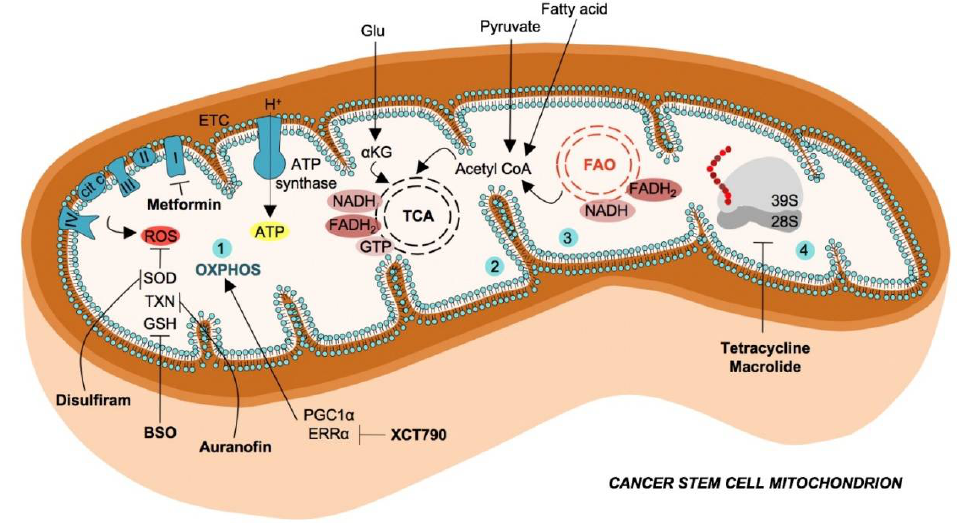
Figure 1. Mitochondrial metabolism in cancer stem cells and therapeutic strategies.Cancer stem cells exhibit enhanced catabolism of glutamate, pyruvate and fatty acids (FAs) to generate intermediate metabolites, whichconvergeintricarboxylicacid(TCA)cycle. Theoxidativephosphorylation(OXPHOS) (1), mediated by the electron transport chain (ETC), use the reducing equivalents (FADH 2 and NADH) produced by tricarboxylic acid (TCA) cycle (2) and fatty acids oxidation (FAO) (3), with the scope of producing ATP molecules. Mitochondrial ETC is also the main endogenous source of reactive oxygen species (ROS), which possess several scavenger enzymes and molecules in CSCs such as superoxide dismutase (SOD), thioredoxin (TXN) and glutathione (GSH). These antioxidant mechanisms are targeted by Disulfiram, auranofin and L-buthionine-sulfoximine (BSO), respectively. Cancer stem cells possess a high number of mitochondria, mitochondrial ribosomes, necessary for protein synthesis are targetable with antibiotics such as tetracyclines and macrolides